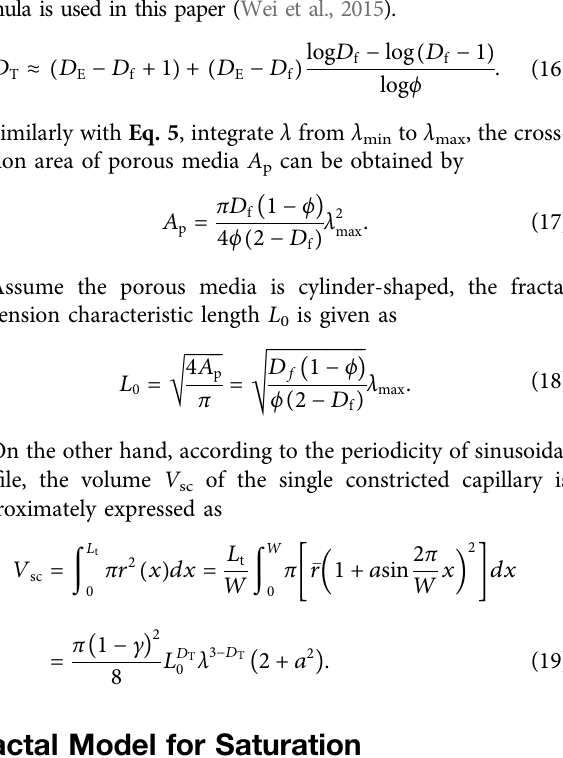
Frontiers in Earth Science |